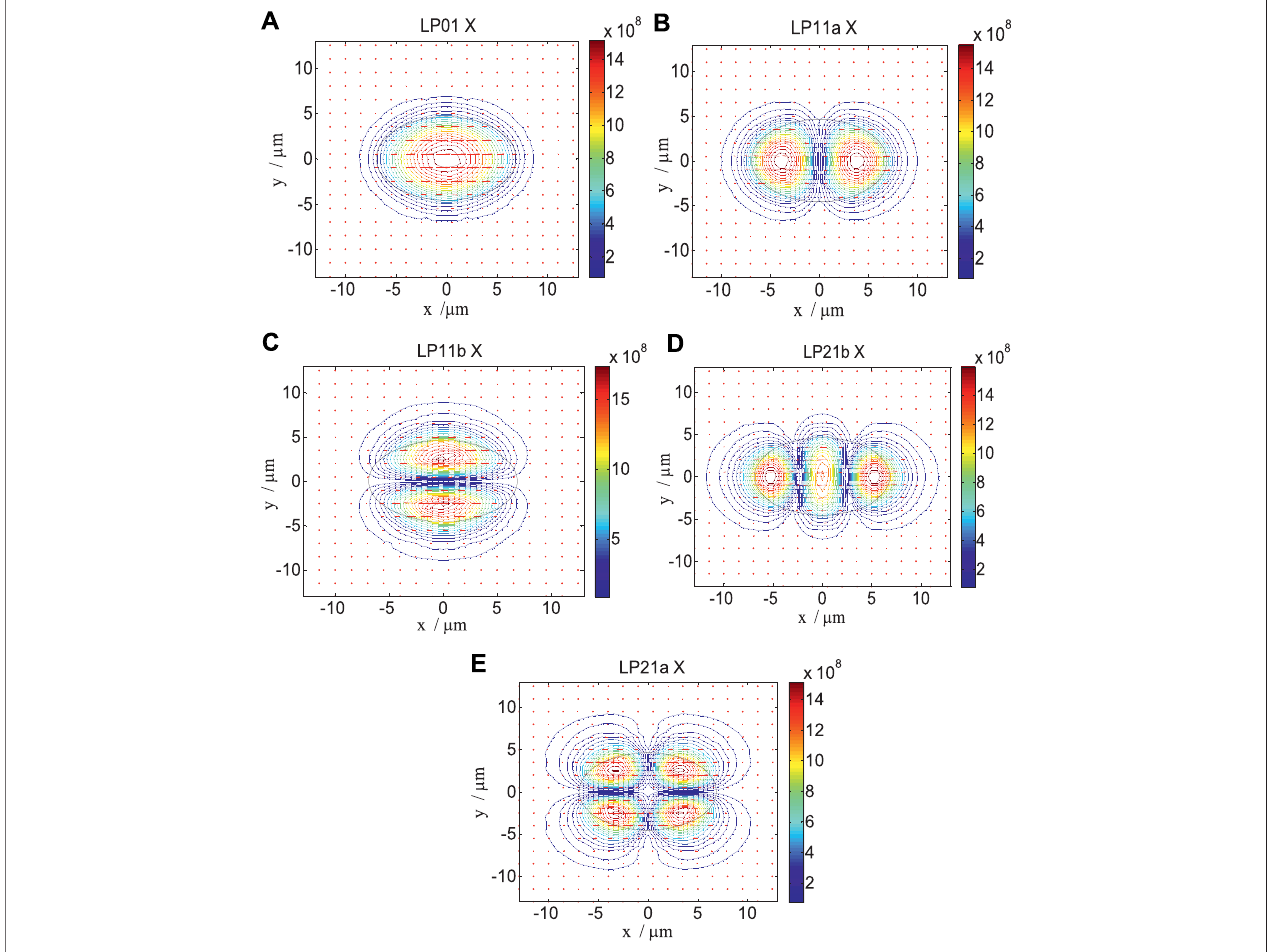
FIGURE 2 | Electric fi eld distribution of fi ve non-degenerate modes LP01 (A) , LP11a (B) , LP11b (C) , LP21b (D) , and LP21a (E) of our proposed EFMF.